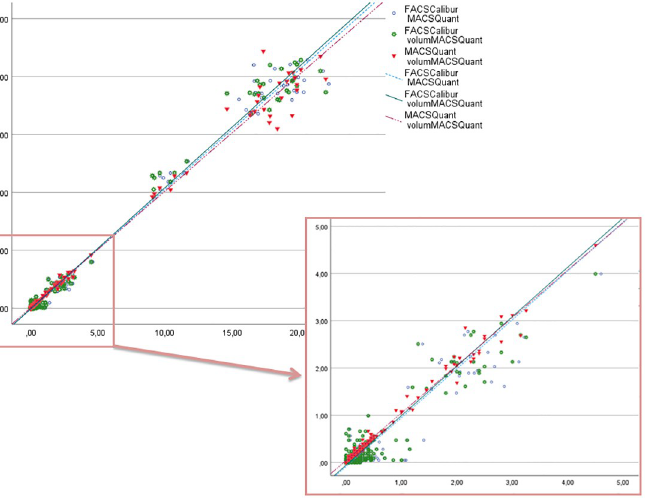
Fig 1. Regression lines. Scatter diagram showing the method comparison between the FACSCalibur bead-based method and the MACSQuant 10 bead-based method (the intercept (95% CI) was -0.085 (-0.183, 0.014), the slope (95% CI) was 1.035 (1.020, 1.050) and R2 was 0.989; p < 0 . 001 ), between the FACSCalibur bead-based method and the MACSQuant 10 volumetric method (the intercept (95% CI) was -0.055 (-0.153, 0.042), the slope (95% CI) was 1.047 (1.032, 1.062) and R2 was 0.989; p < 0 . 001 ), and between the MACSQuant 10 bead-based method and the MACSQuant 10 volumetric method (the intercept (95% CI) was 0.042 (-0.043, 0.127), the slope (95% CI) was 1.007 (0.994, 1.020) and R2 was 0.991; p < 0 . 001 ). The X-axis and Y-axis represent the number of leukocytes per μ